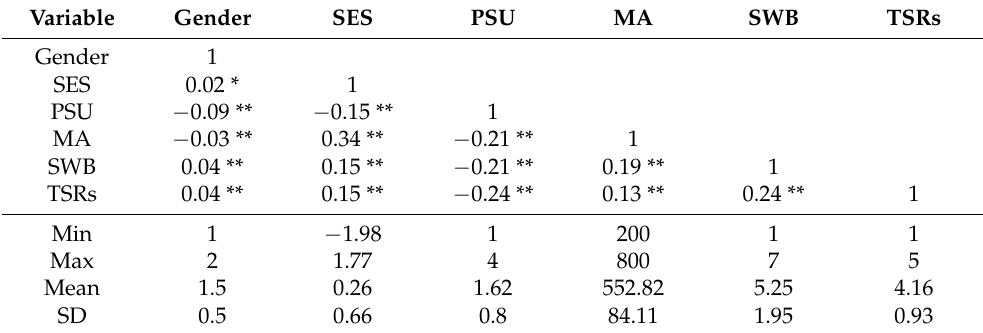
Table 1. Min, max, mean, standard deviations, and correlations among all the variables.